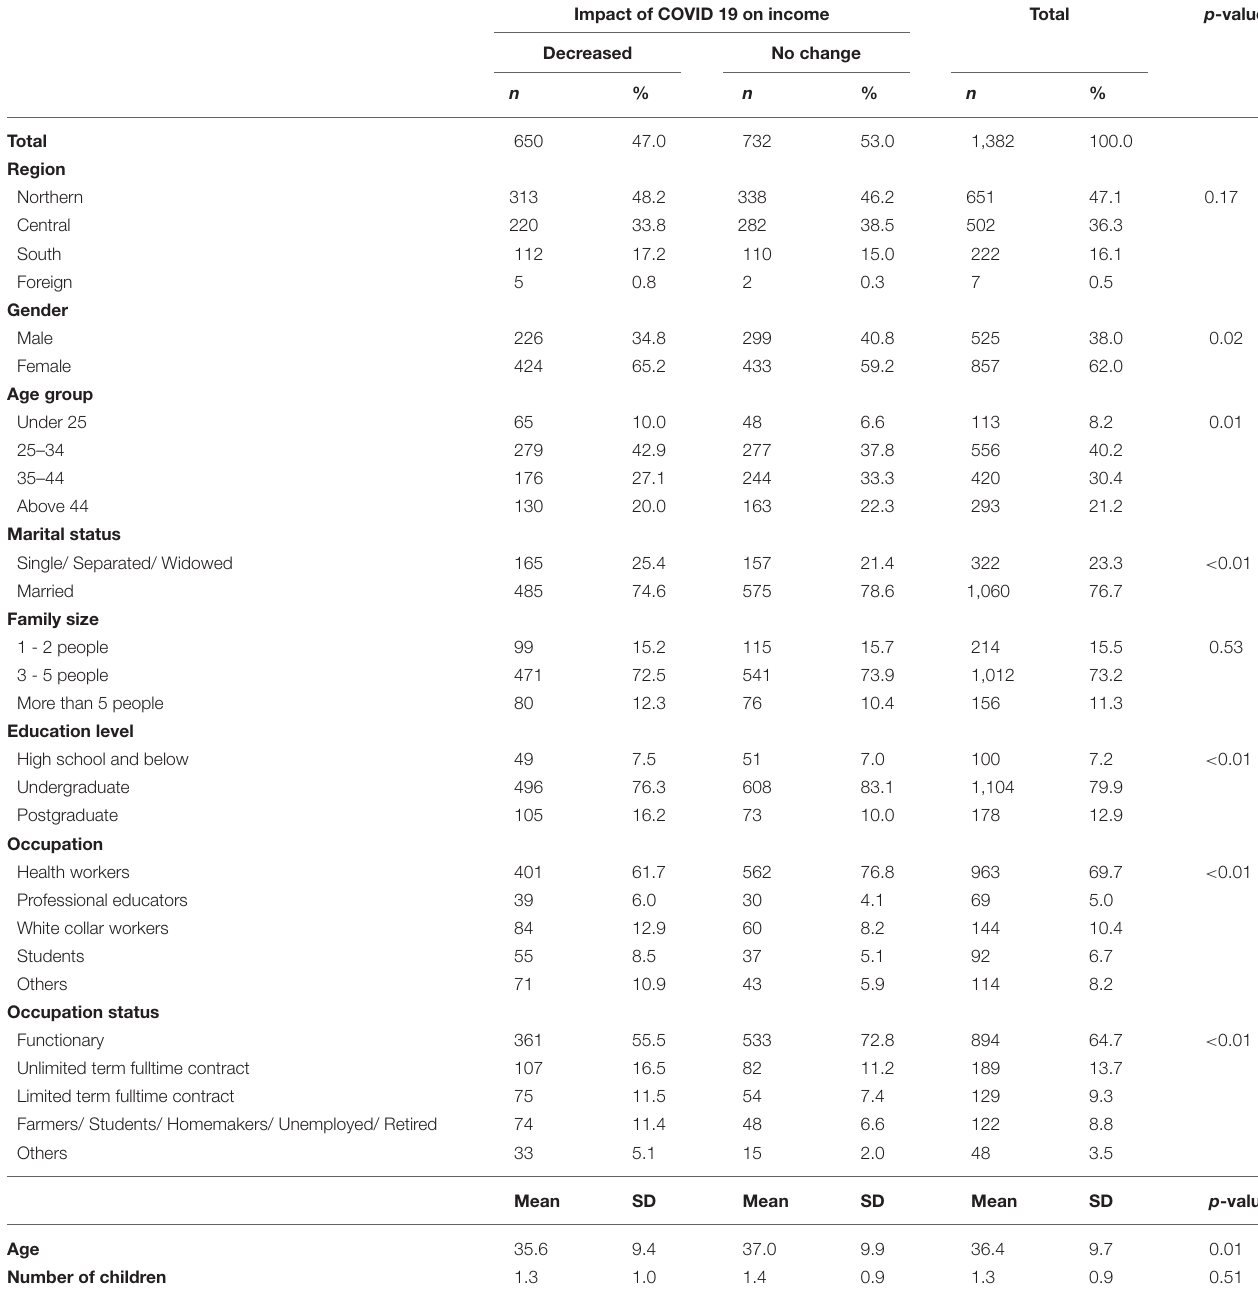
TABLE 1 | Socioeconomics characteristics of participants.